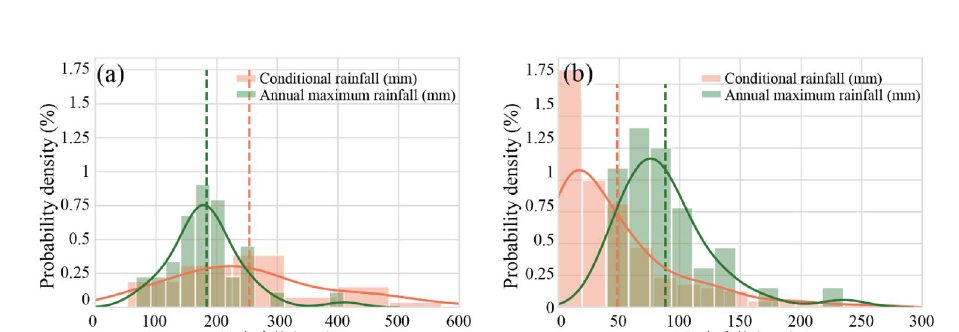
Fig. 5 Simulated surges and rainfall under the joint copula model. a Catchment A2; b Catchment C4. The vertical solid line represents the value of the surge at 50 year return period, while the dashed lines represent the range percentiles beside the solid line